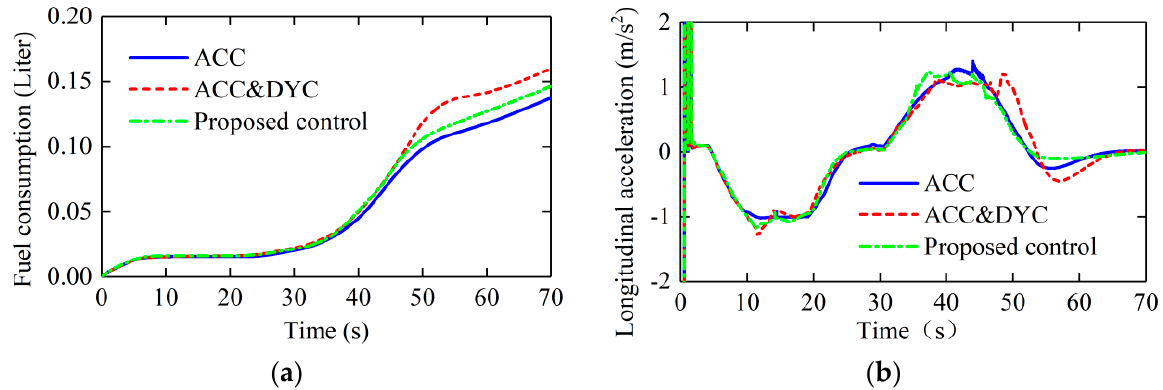
Figure 17. Fuel consumption and longitudinal acceleration: ( a ) fuel consumption; ( b ) longitudinal acceleration.